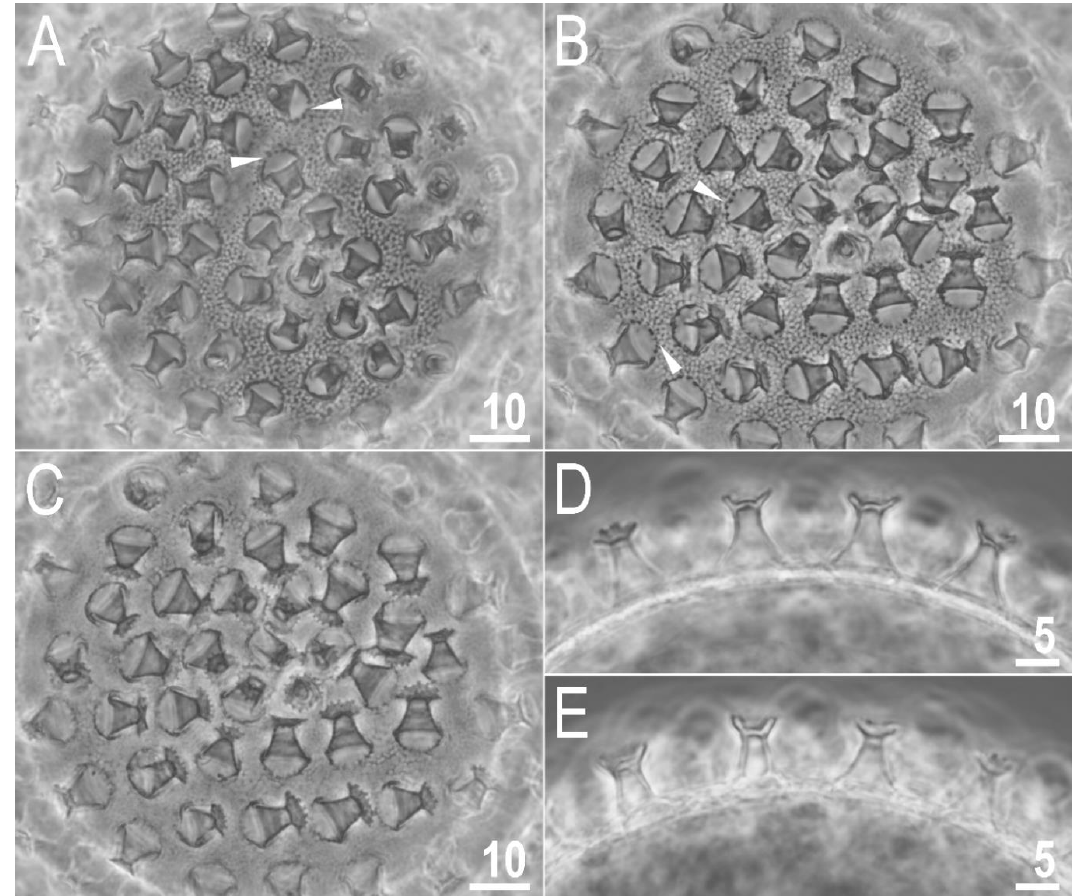
Figure 7. Macrobiotus rebecchii sp. nov. PCM images of the egg under ×1000 magnification. ( A , B ) egg surface; ( C ) egg surface, focus on egg processes and terminal discs; ( D , E ) midsections of egg processes. The filled flat arrowheads indicate thickenings around the processes bases. Scale bars in μm.